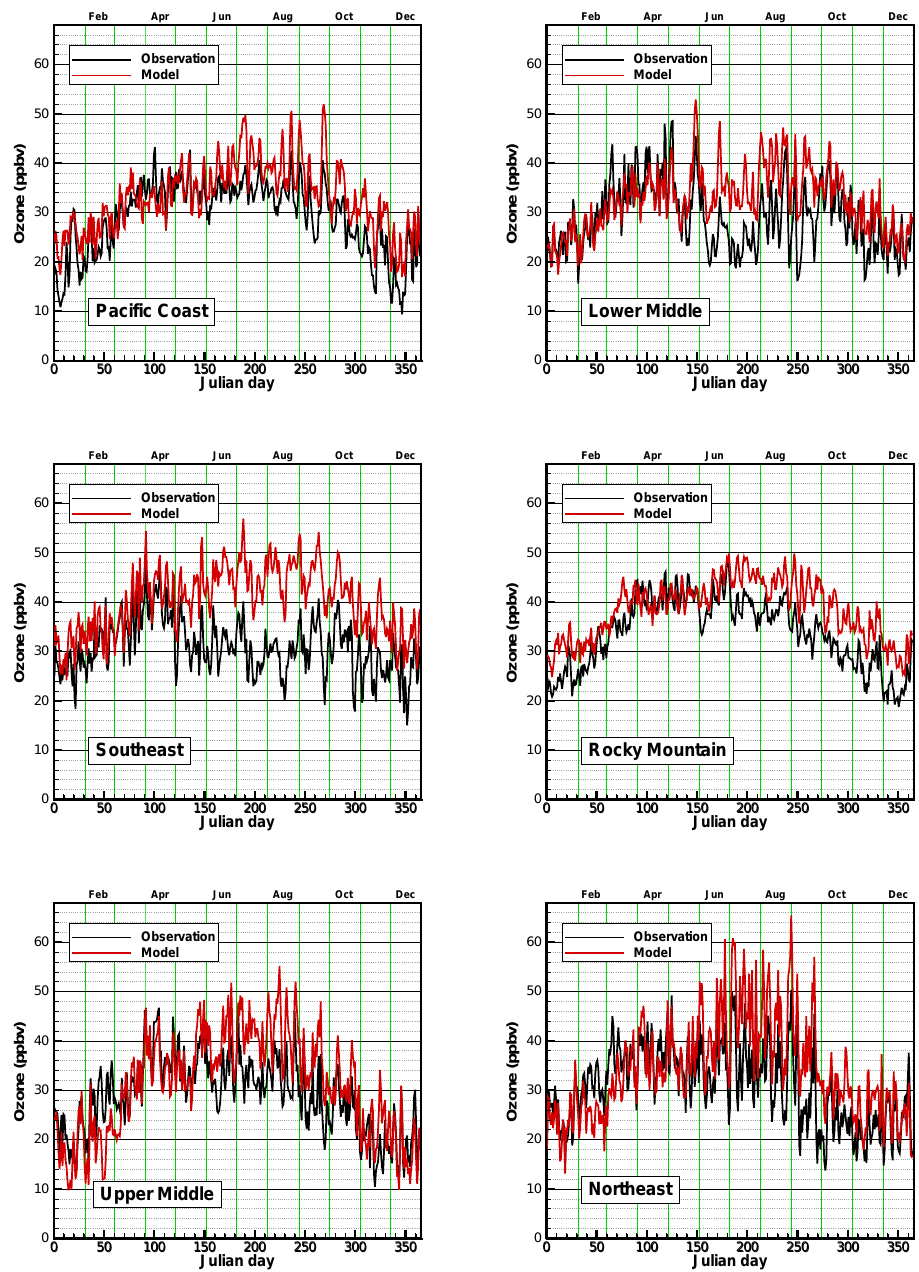
Fig. 6. Daily average ozone concentrations in 2010 for each of the six regions listed in Fig. 1.